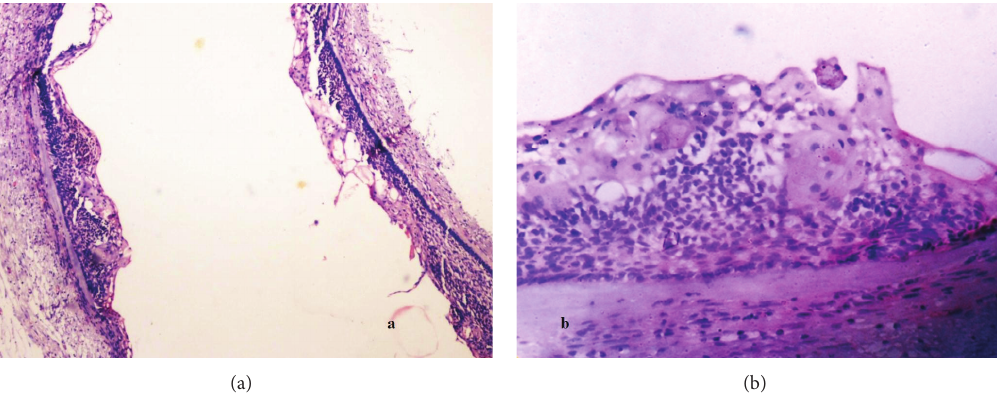
Figure 6: H & E stained section showing cystic lining with ghost cells and stroma with dysplastic dentin, (a) magnification × 40, (b) magnification ×